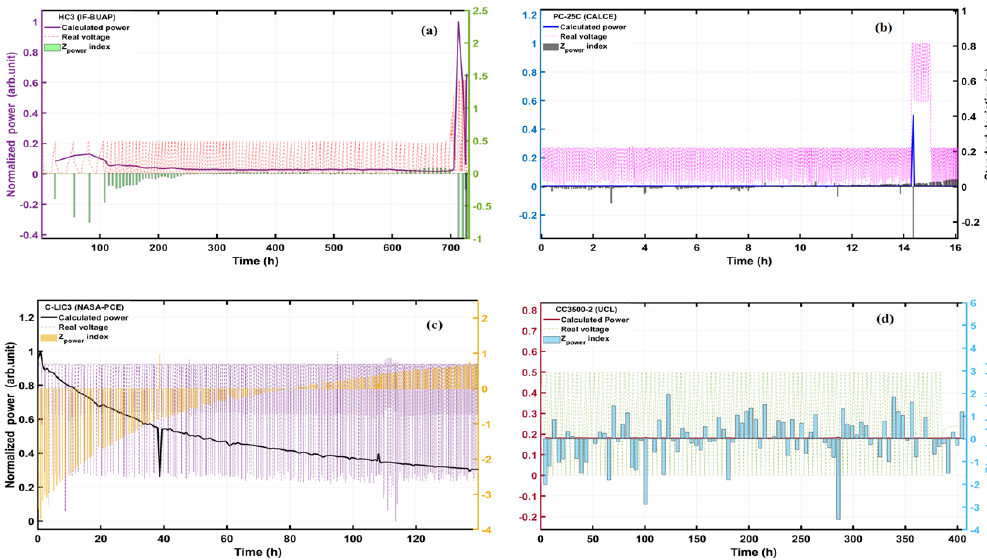
Figure 8. Calculated power index, ( Z Power ) function and normalized voltage for ( a ) HC3, ( b ) PC-25C, ( c ) C-LIC3 and ( d ) CC3500-2